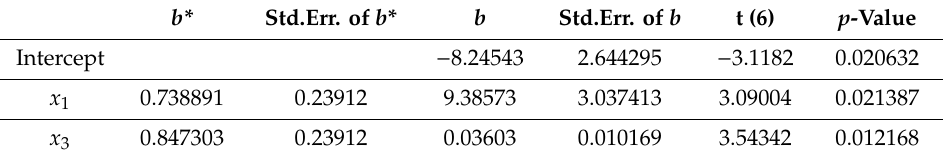
Table 7. Regression summary for the dependent variables ( b * is normalized regression coe ffi cients).